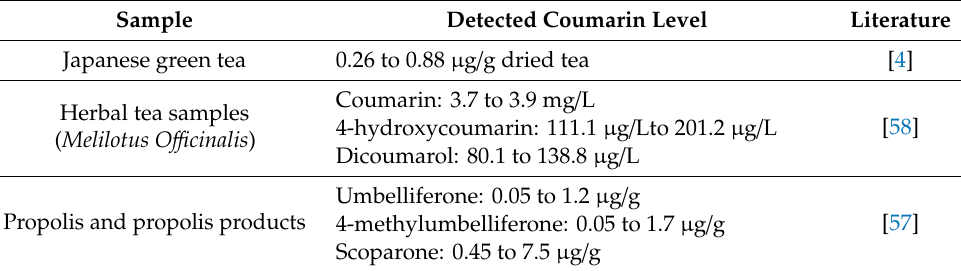
Table 3. Coumarin-containing foods used in human